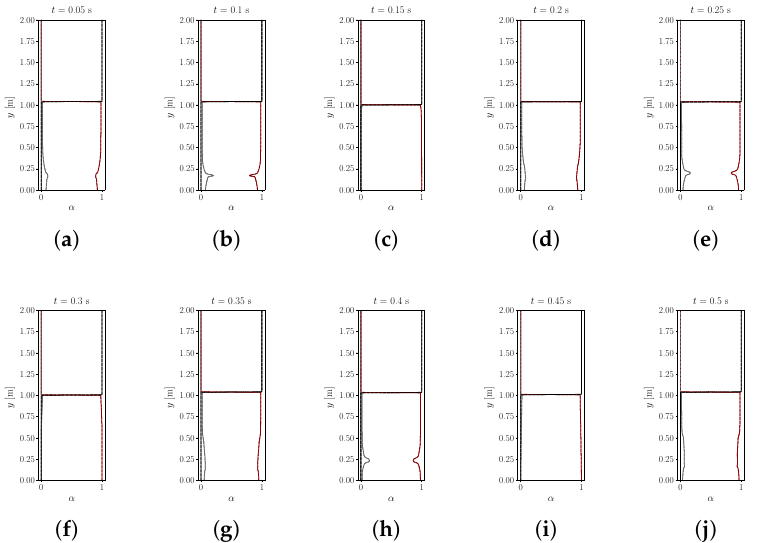
Figure 17. Void fraction profiles over the y-axis for ( a – j ) t = 0.05 s to t = 0.5 s. Legend: for the grid A α l ( ), for the grid B α l ( ), α v ( ), α nc ( ).